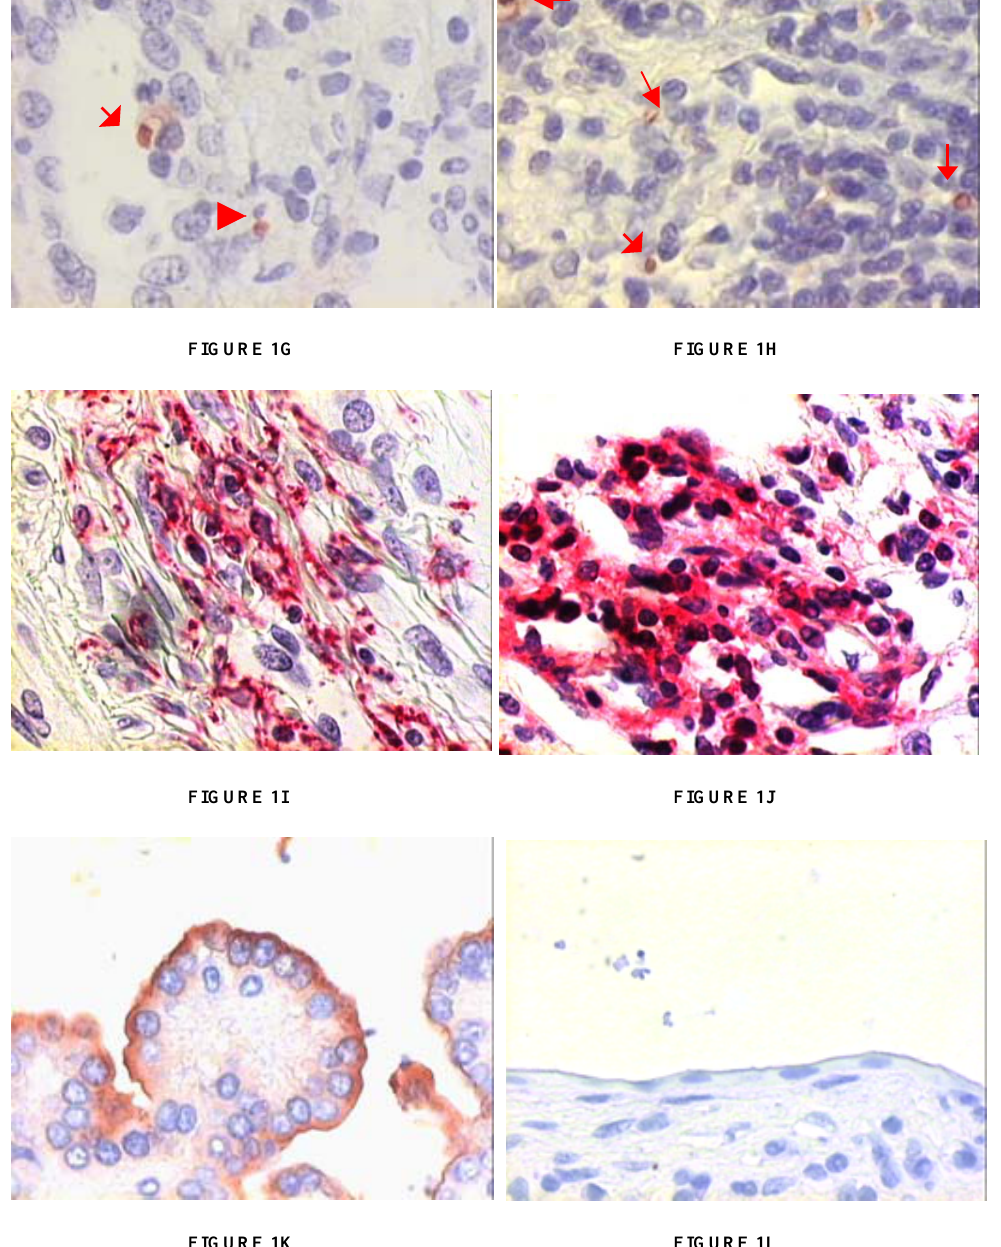
that was 39-fold higher than the corresponding normal control (1.19 ± 0.15 and 0.03 ± 0.02, respectively) (Fig. 2). Of note, the PI value of the epithelial lining noncystic tubules was also higher than that lining the cysts (1.19 ± 0.15 and 0.47 ± 0.09, p < 0.001). The PI values showed no consistent correlation with the epithelial morphology, as it was noted that the hyperplastic epithelium did not show a higher degree of proliferation compared to other types. There was a great variation in the number of PCNA-positive nuclei between individual cystic and noncystic structures in the same and between the sections, and, not infrequently, clusters of PCNA-positive nuclei were noted grouped in the cystic and noncystic structures as well as the interstitium